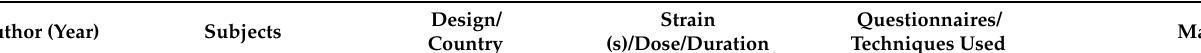
Table 3. Studies focused on the use of probiotics in anxiety